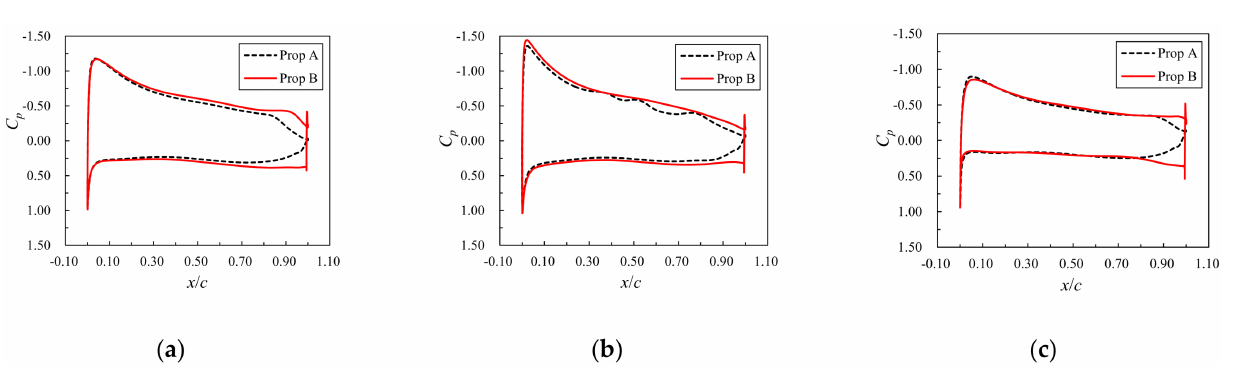
Figure 38. Pressure coefficient distribution on different cross-sectional airfoils at State 1: ( a ) r / R = 0.5; ( b ) r / R = 0.75; ( c ) r / R = 0.95.